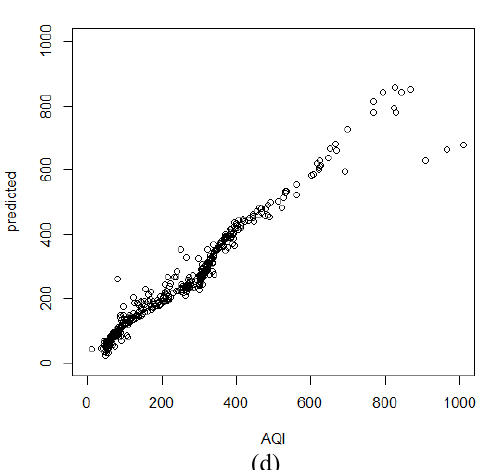
Figure 6. Predicted Vs Observed Values of